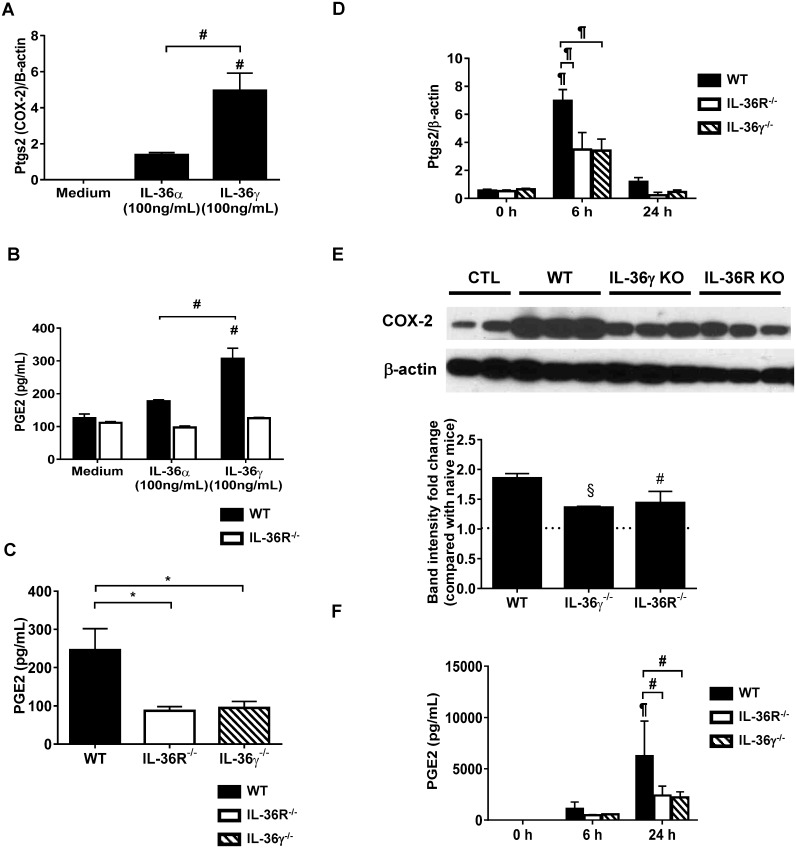
IL-36γ induced COX-2 mRNA expression and the production of PGE2 in PMs during P. aeruginosa infection.(A-C) Primary PMs isolated from WT and IL-36R-/- mice were treated with recombinant IL-36α (100ng/ml) and IL-36γ (100ng/ml) for 24 h. (A) The expression of prostaglandin-endoperoxide synthase 2/cyclooxygenase 2 (Ptgs2/COX-2) mRNA in PMs was analyzed by real-time PCR. (B) The protein production of prostaglandin e 2 (PGE2) in CM by PMs was examined by ELISA. (C) PMs isolated from WT, IL-36R-/- and IL-36γ-/- mice were treated with live P. aeruginosa at a MOI 10 for 24 h. (C) PGE2 production in CM were examined. Data (means ± SEM) are representative of two independent experiments. * p<0.05, # p<0.01, significant compared with medium only or as indicated. (D-F) WT, IL-36R-/- and IL-36γ-/- mice were intratracheally infected with 2.0 × 105 CFU P. aeruginosa. (D) PTGS2 mRNA and (F) the production of PGE2 in BAL in infected-WT, IL-36R-/- and IL-36γ-/- mice were examined (n = 4 per each group). (F) The expression of COX-2 in the lungs was determined by Western blotting. Band intensity represents relative density compared with β-actin, and fold changes compared with the lungs of naïve WT mice were presented. # p<0.01, ¶ p<0.0001, significant compared with untreated mice or as indicated.